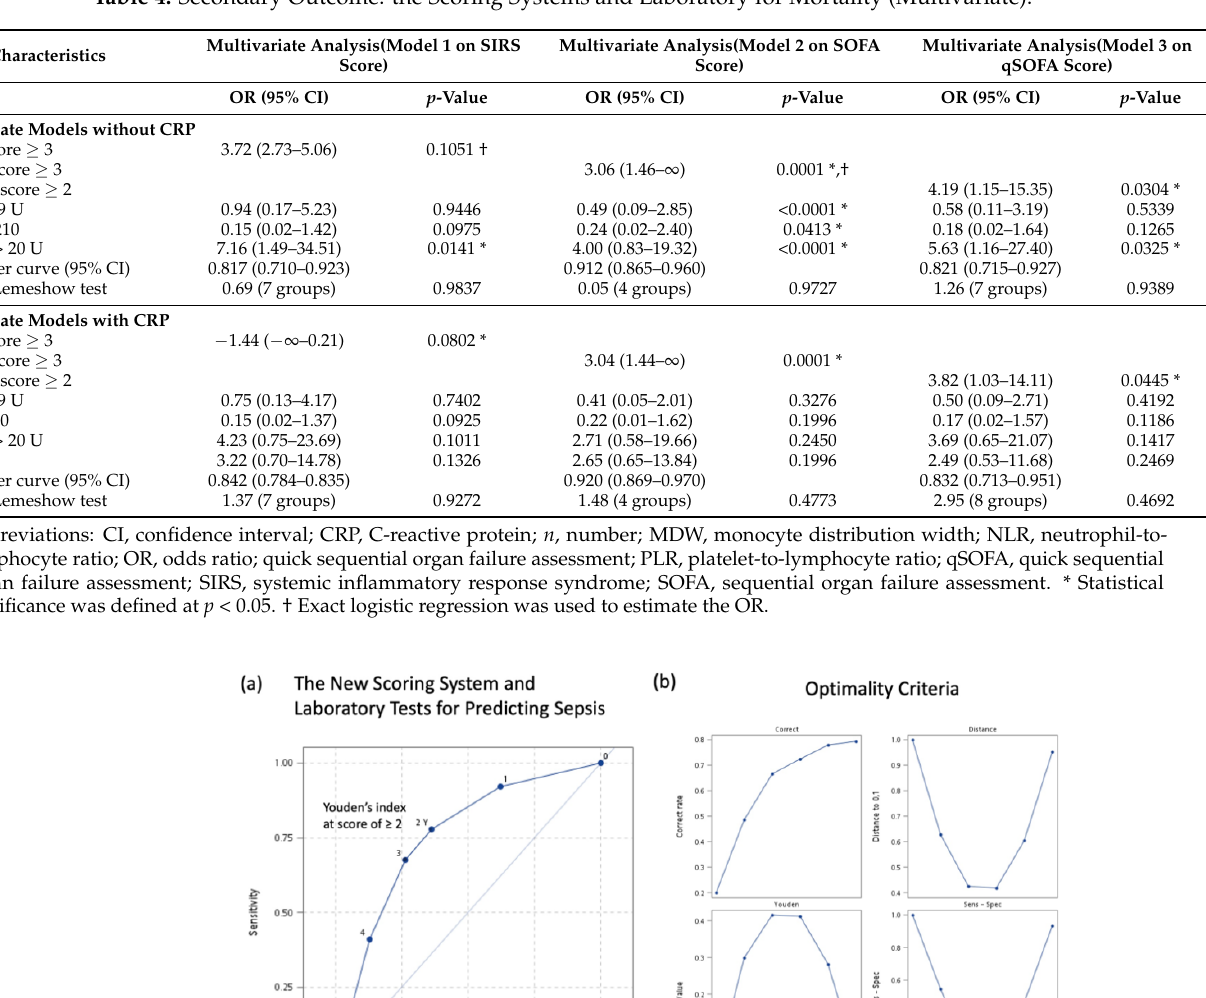
Table 4. Secondary Outcome: the Scoring Systems and Laboratory for Mortality (Multivariate).